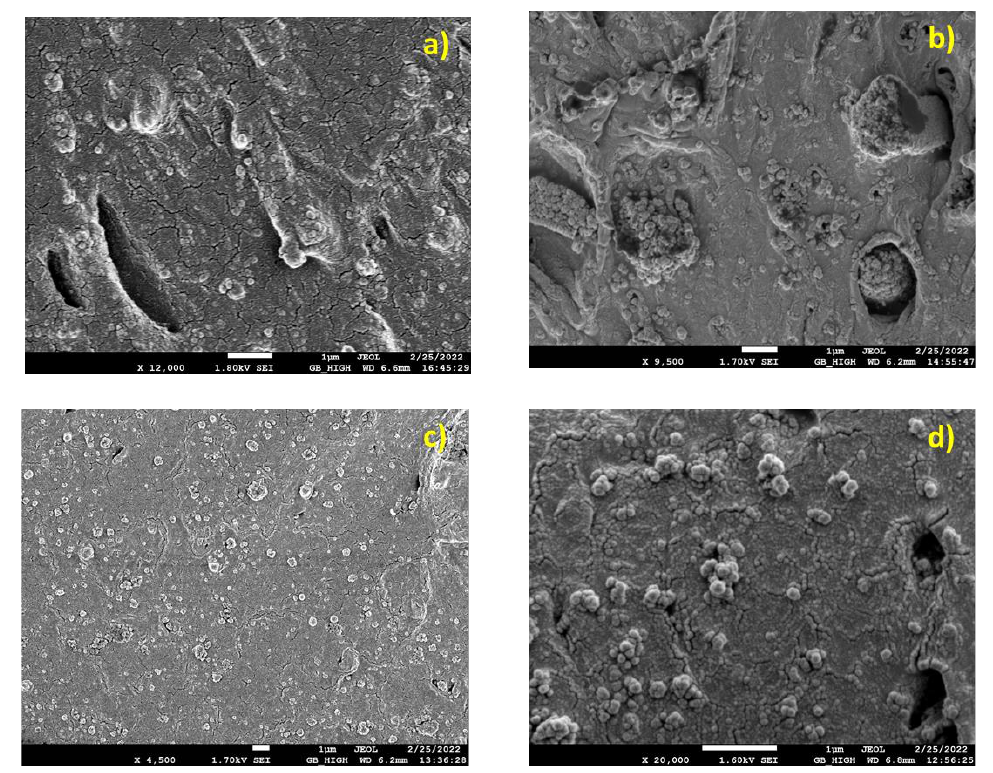
Figure 2. SEM micrographs of PLA/SiO 2 nano-composites, ( a ) PLA/13-22, ( b ) PLA/15-35, ( c ) PLA/18-35, ( d ) PLA 55-75.